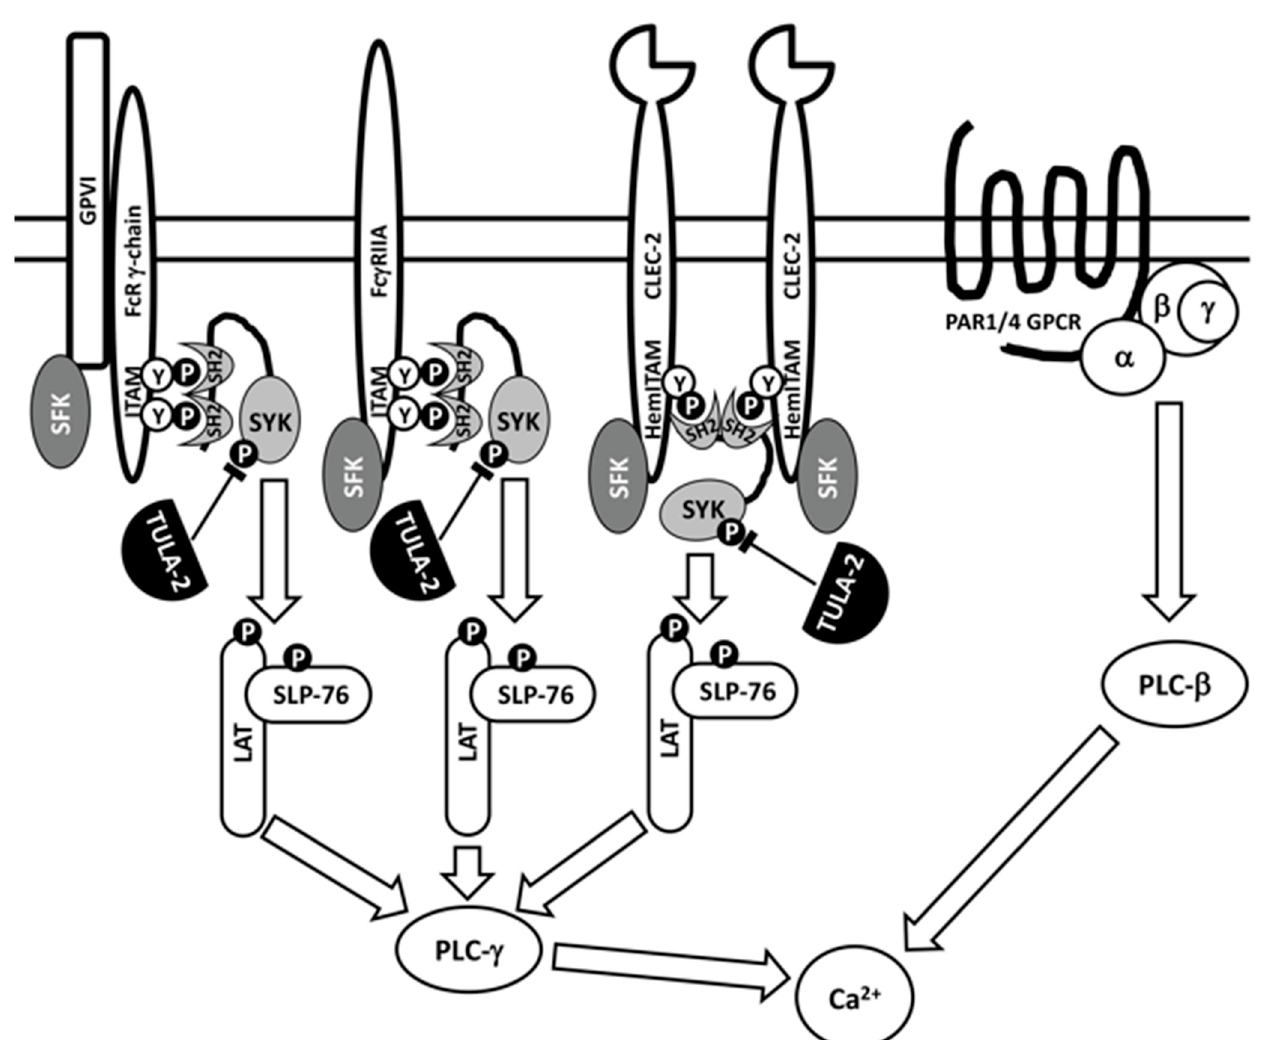
Figure 2. TULA-2 downregulates platelet signaling mediated by Syk. Major upstream events of platelet signaling through immunoreceptor tyrosine-based activation motif (ITAM)- or hemITAM (hemi-ITAM)-bearing receptors and G-protein-coupled receptors (GPCR) are schematically represented. Early signaling events through ITAM- or hemITAM-bearing receptors involve Src-family protein tyrosine kinases (SFKs) and Syk, a protein tyrosine kinase interacting with phosphotyrosines of ITAMs and hemITAMs through its tandem SH2 domains (see details in the text). This scheme illustrates how Syk, following activation through a receptor, phosphorylates its protein substrates, including LAT and SLP-76 adaptors, which interact with other signaling proteins activating PLC- γ , thus increasing the intracellular Ca 2+ concentration. Activation through the protease-activated receptor (PAR), which is a GPCR, increases Ca 2+ in a Syk-independent fashion. TULA-2 downregulates Syk-mediated receptor signaling by dephosphorylating Syk phosphotyrosines, which positively regulate activity of this kinase. Various events dependent on receptor-induced Syk activation are downregulated by TULA-2, not only those depicted in this figure.